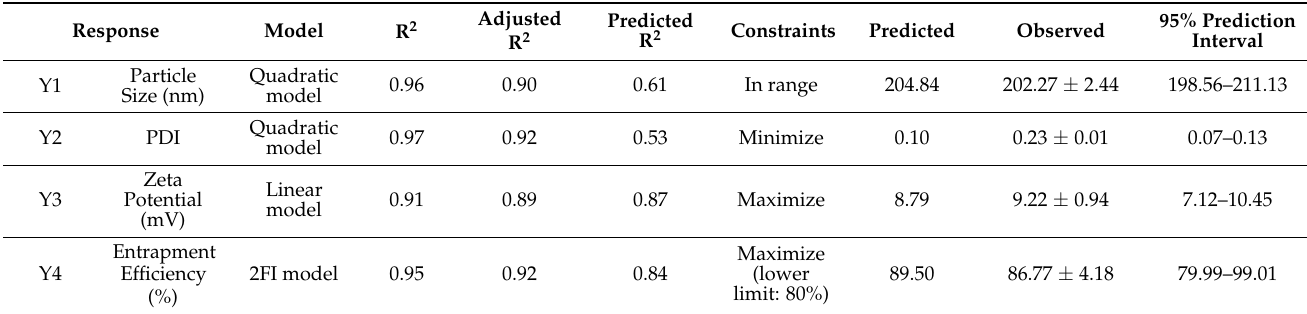
Table 1. Model summary statistics of the different models for tested responses, constraints for optimization of H/CS/PLGA NPs formulation, and the predicted and observed values of the